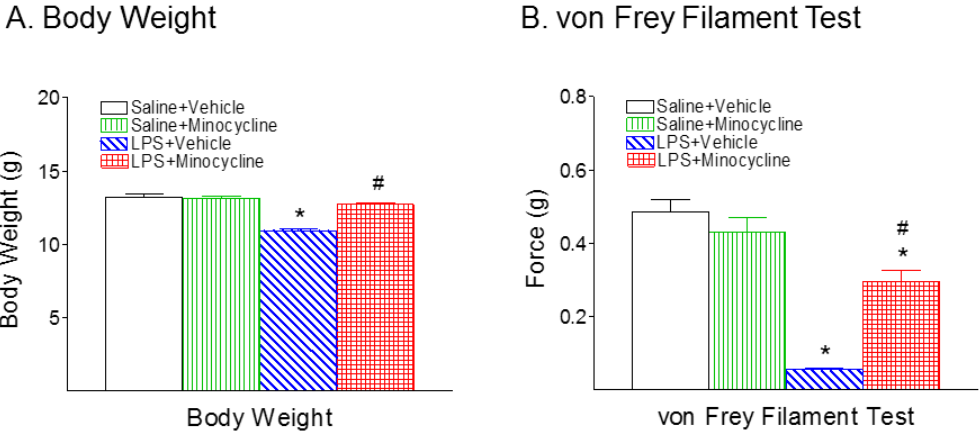
Figure 1. Minocycline attenuated systemic lipopolysaccharide (LPS)-induced body weight loss ( A ), and allodynia in the von Frey filament test ( B ) in the neonatal postnatal day 6 (P6) rats. ( A ), Systemic LPS treatment (P5) resulted in body weight loss in the P6 rats. Treatment with minocycline significantly reduced the LPS-induced body weight loss in the P6 rats. ( B ), Systemic LPS treatment (P5) resulted in a reduction of the withdrawal threshold (g force) for hind paw removal from a mechanical stimulation in the P6 rats. Treatment with minocycline significantly reduced LPS-induced pain hypersensitivity in the neonatal rats. The results are expressed as the mean ± SEM of 16 animals in each group. The results from body weight were analyzed by two-way ANOVA, followed by the Student–Newman–Keuls test. The results from the von Frey filament test were analyzed by Kruskal–Wallis one-way-ANOVA on ranks, followed by the Dunn’s test. * p < 0.05 represents a significant difference for the LPS + Vehicle group, or LPS + Minocycline group compared with the Saline + Vehicle group. # p < 0.05 represents a significant difference for the LPS + Minocycline group compared with the LPS + Vehicle group. ( n = 16).